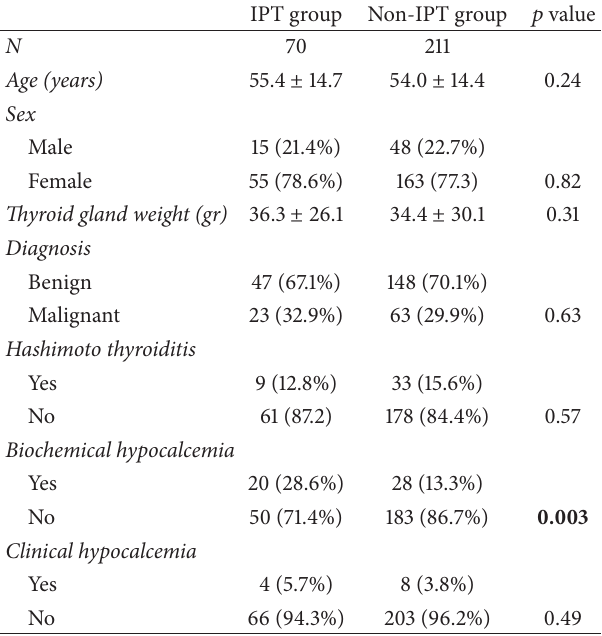
Table 3: Comparison of incidental parathyroidectomy (IPT) and nonincidental parathyroidectomy (non-IPT)